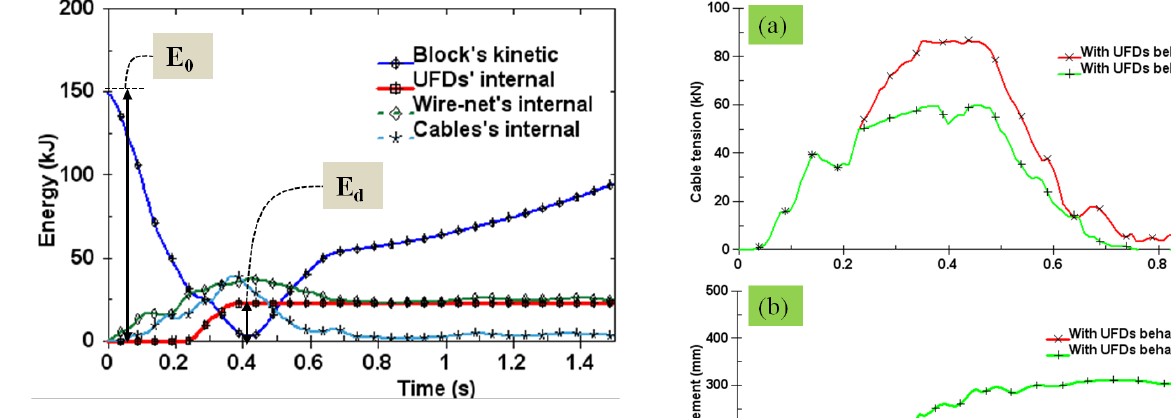
Figure 10. Numerically simulated time history highlighting the energy dissipation by the 2 Fig. 10. Numerically simulated time history highlighting the en- ergy dissipation by the UFDs in the the R-LPR in the FST, where UFDs in the the R-LPR in the FST, where the block carrying 150 kJ of impact energy hit the 3 the block carrying 150kJ of impact energy hit the structure at the structure at the predefined point in the wire-net. 4 predefined point in the wire-net.